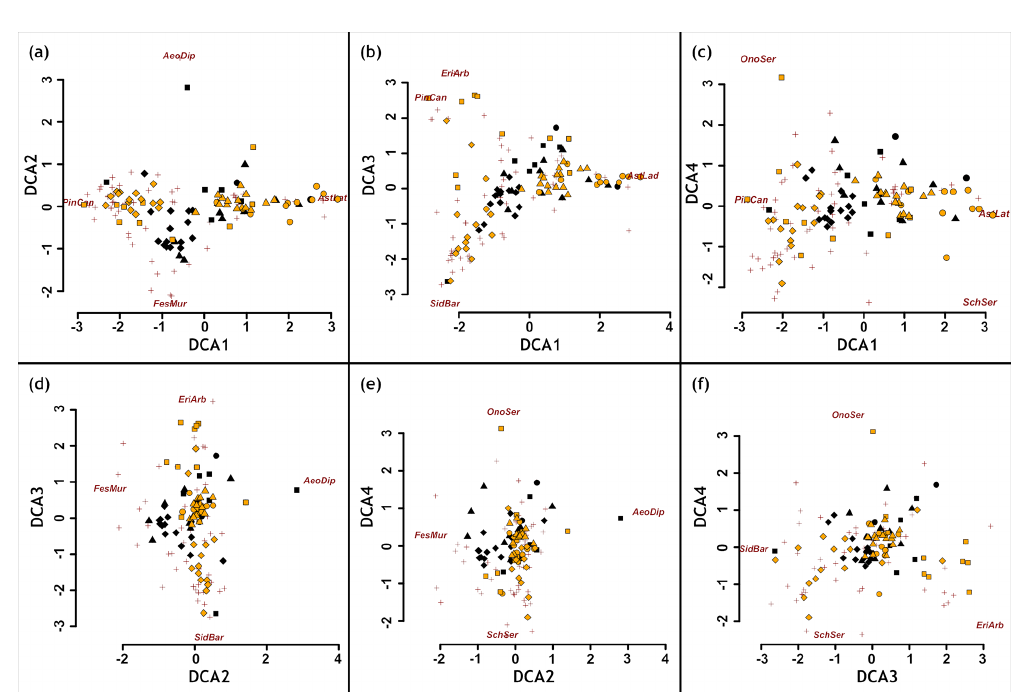
Figure A1. Detrended correspondence analysis (DCA) shows no clear difference between phonolite and basaltic rock vegetation. Yellow dots show phonolite plots, black dots basalt plots, and dark red a subset of species centroids. Species names chosen based on the most extreme values along the gradients.